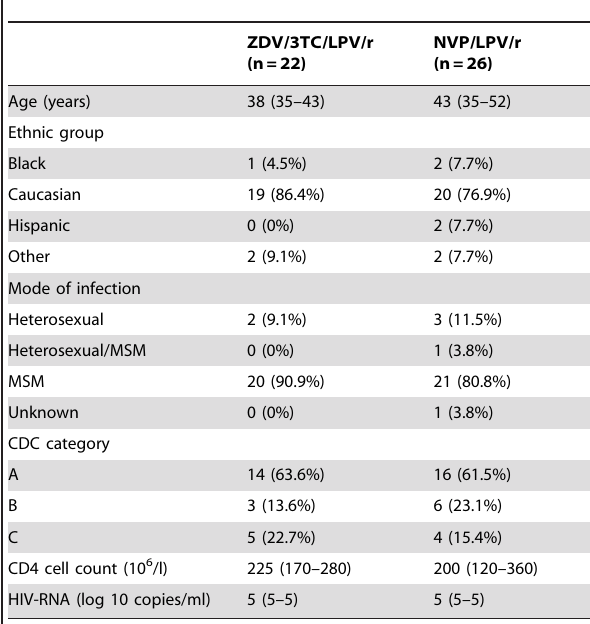
Table 1. Baseline characteristics of the study